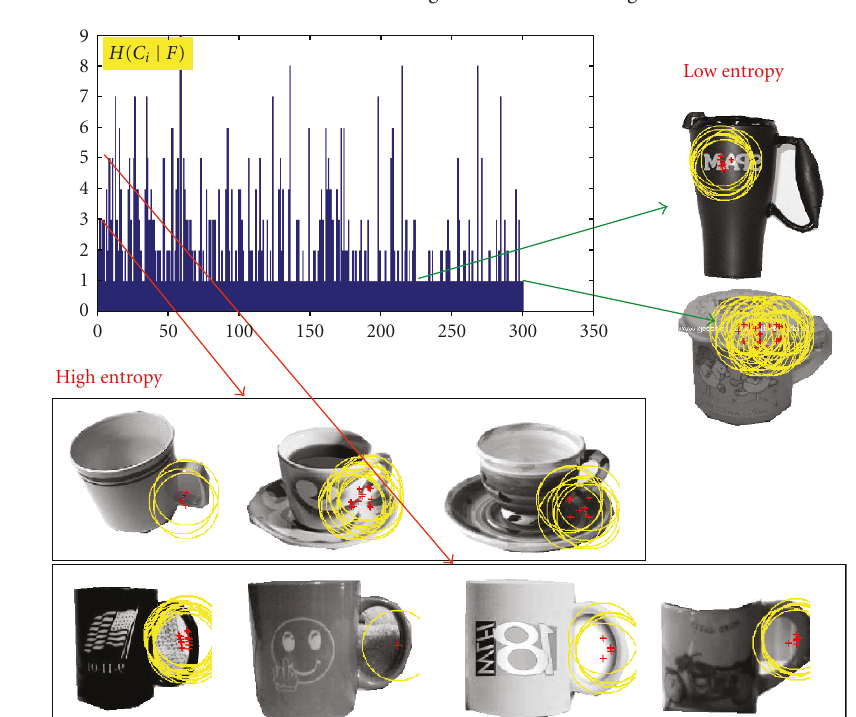
Figure 15: Observation for repeatable parts (high entropy) and surface marking parts (low